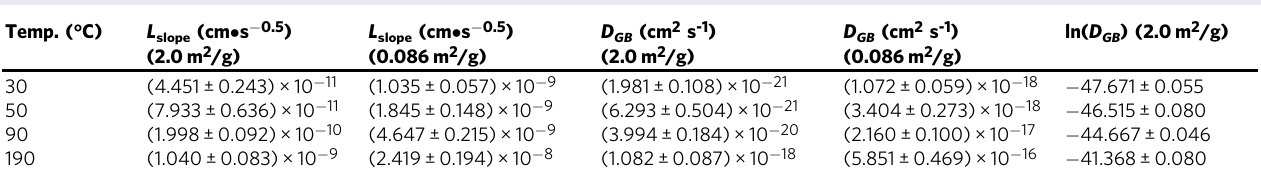
Table 1 Calculated grain boundary diffusion coef fi cients. Temp. (°C) L slope (cm (cid:129) s − 0.5